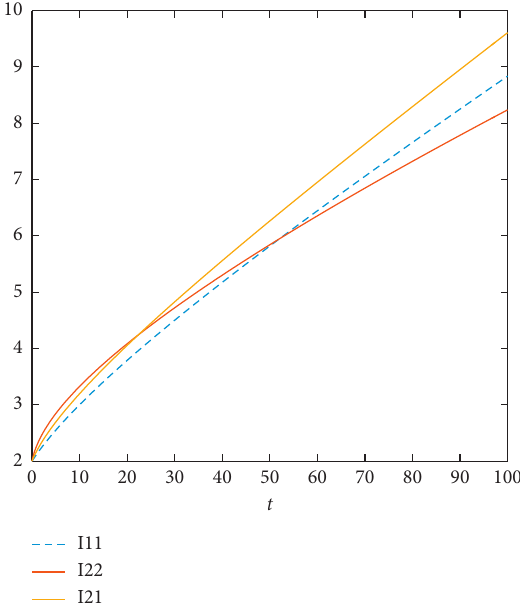
Figure 5: Abatement levels of upstream and